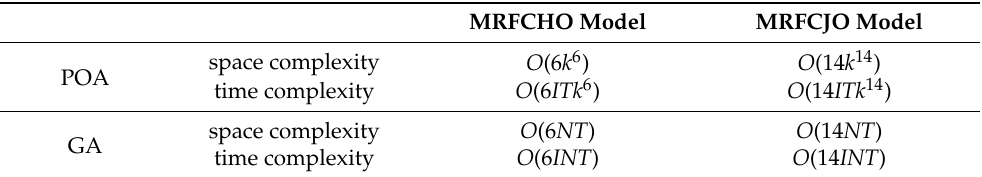
Table 3. The complexity of POA and GA.